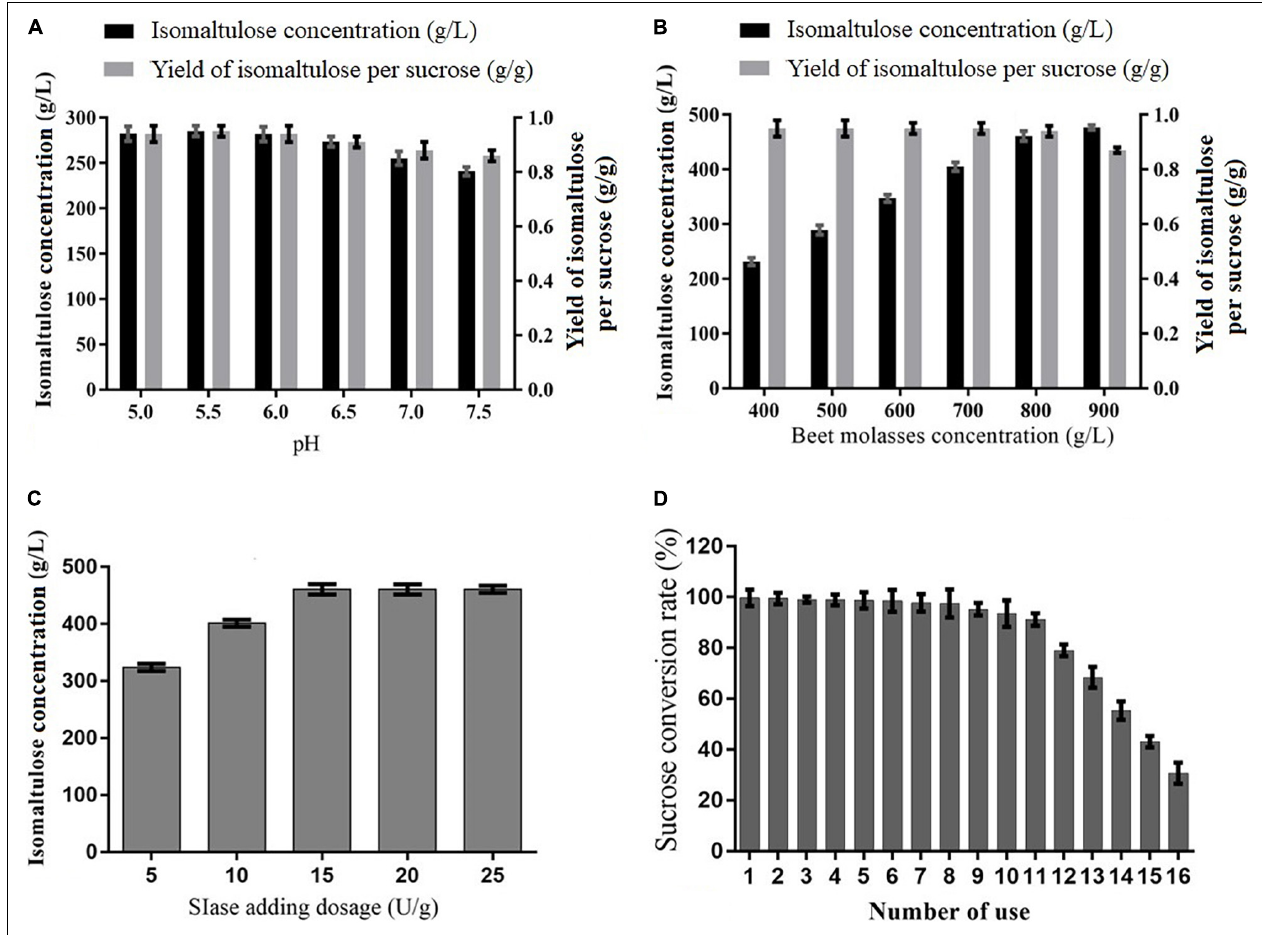
FIGURE 3 | Effects of different factors on isomaltulose production from pretreated beet molasses (BM) by immobilized SIase. (A) pH, (B) pretreated BM concentration, (C) SIase adding dosage, and (D) the effect of recycling number of immobilized SIase on sucrose conversion